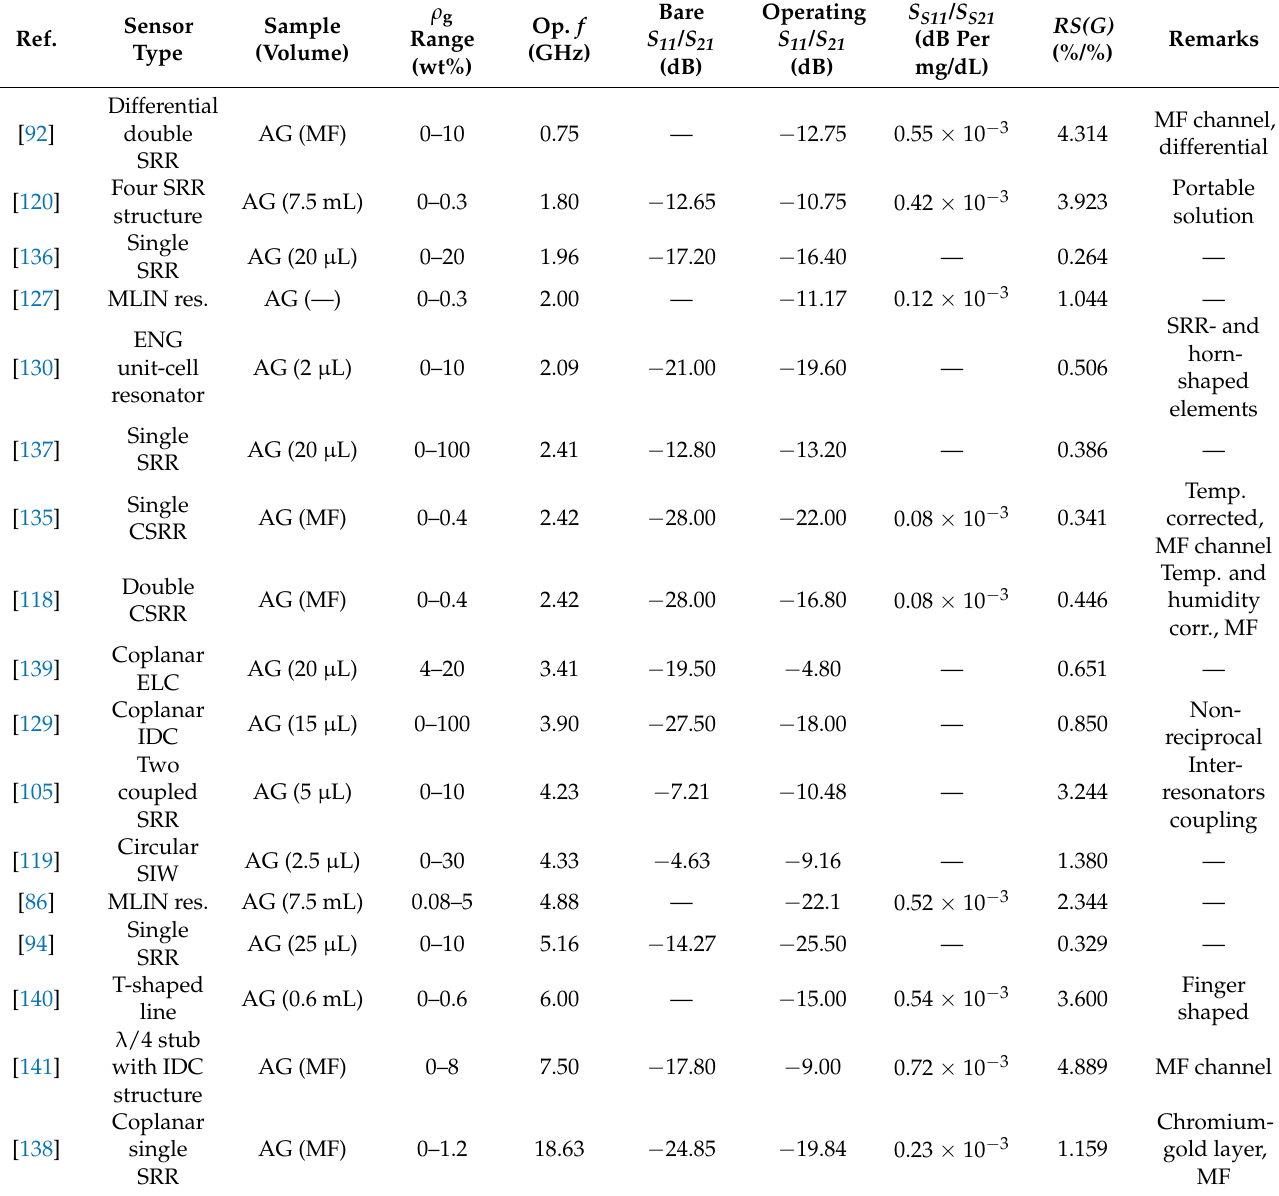
Table 2. Insertion/return loss-based sensors. AG = aqueous glucose solutions; (C)ELC = (complementary) electric LC resonator; IDC = interdigital capacitor; MLIN = microstrip line; SRR = split-ring resonator; TX = transmission.